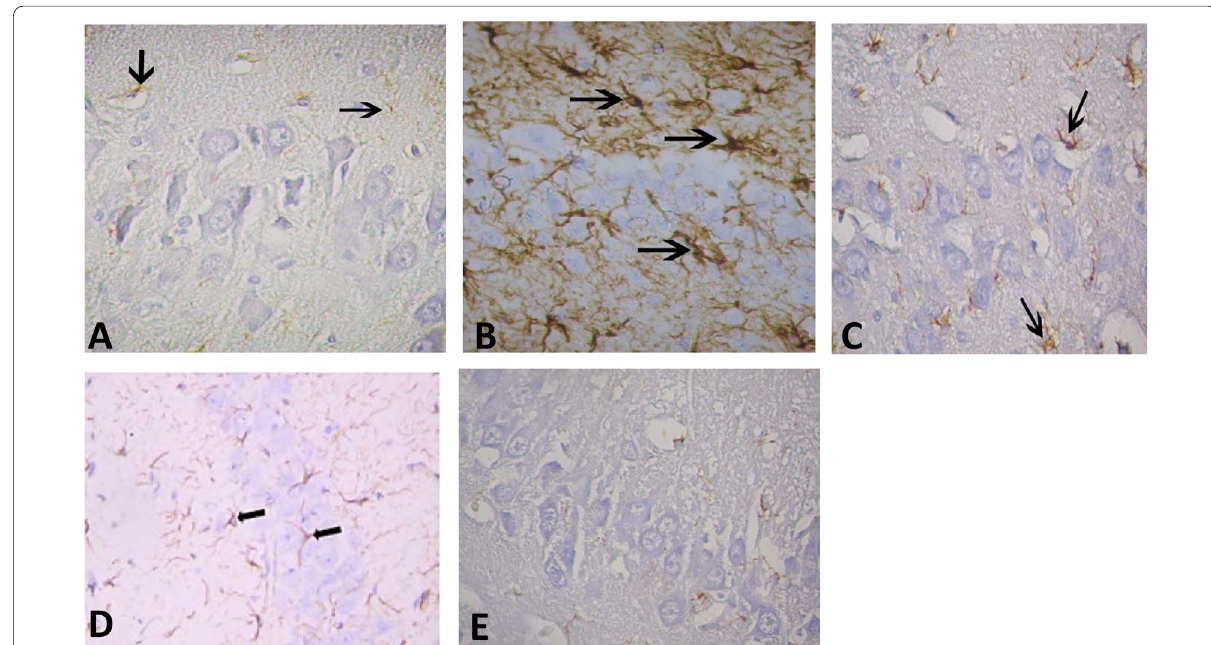
Fig. 3 Glial fibrillary acidic protein (GFAP) stained sections of hippocampus (CA3) region. A Control non ketamine treated rats showed few GFAP positive astrocytes. B Ketamine treated rats showed substantial number of GFAP positive astrocytes with many tall processes compared to control non ketamine treated GROUP. C Tamoxifen/ketamine treated rats showed some positive astrocytes with tall processes. D Risperidone/ketamine treated rats showed few GFAP positive astrocytes with tall processes. E Tamoxifen/risperidone/ketamine treated rats showed positive astrocytes were significantly decreased compared to ketamine treated and risperidone/ketamine treated groups comparable to control